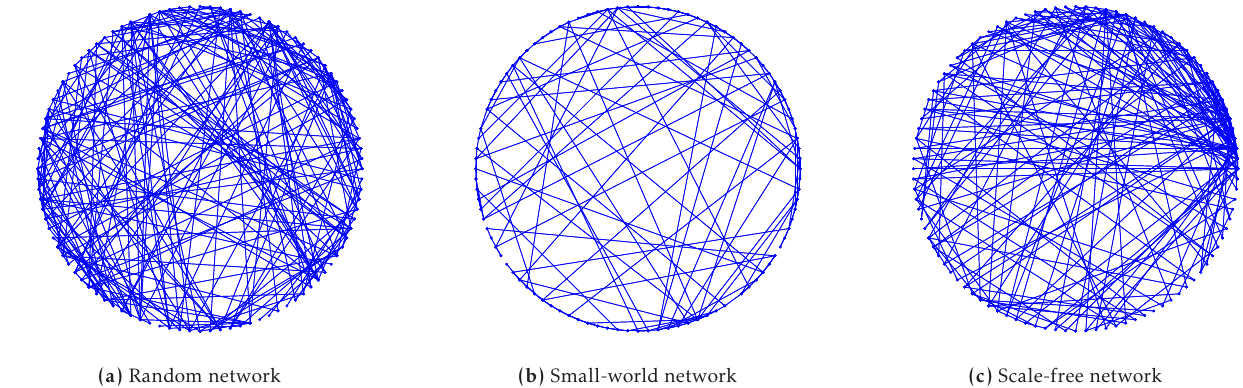
Figure 4. The network topologies used in the simulations. The average node degree for each network is 4 , and each network includes 100 nodes.